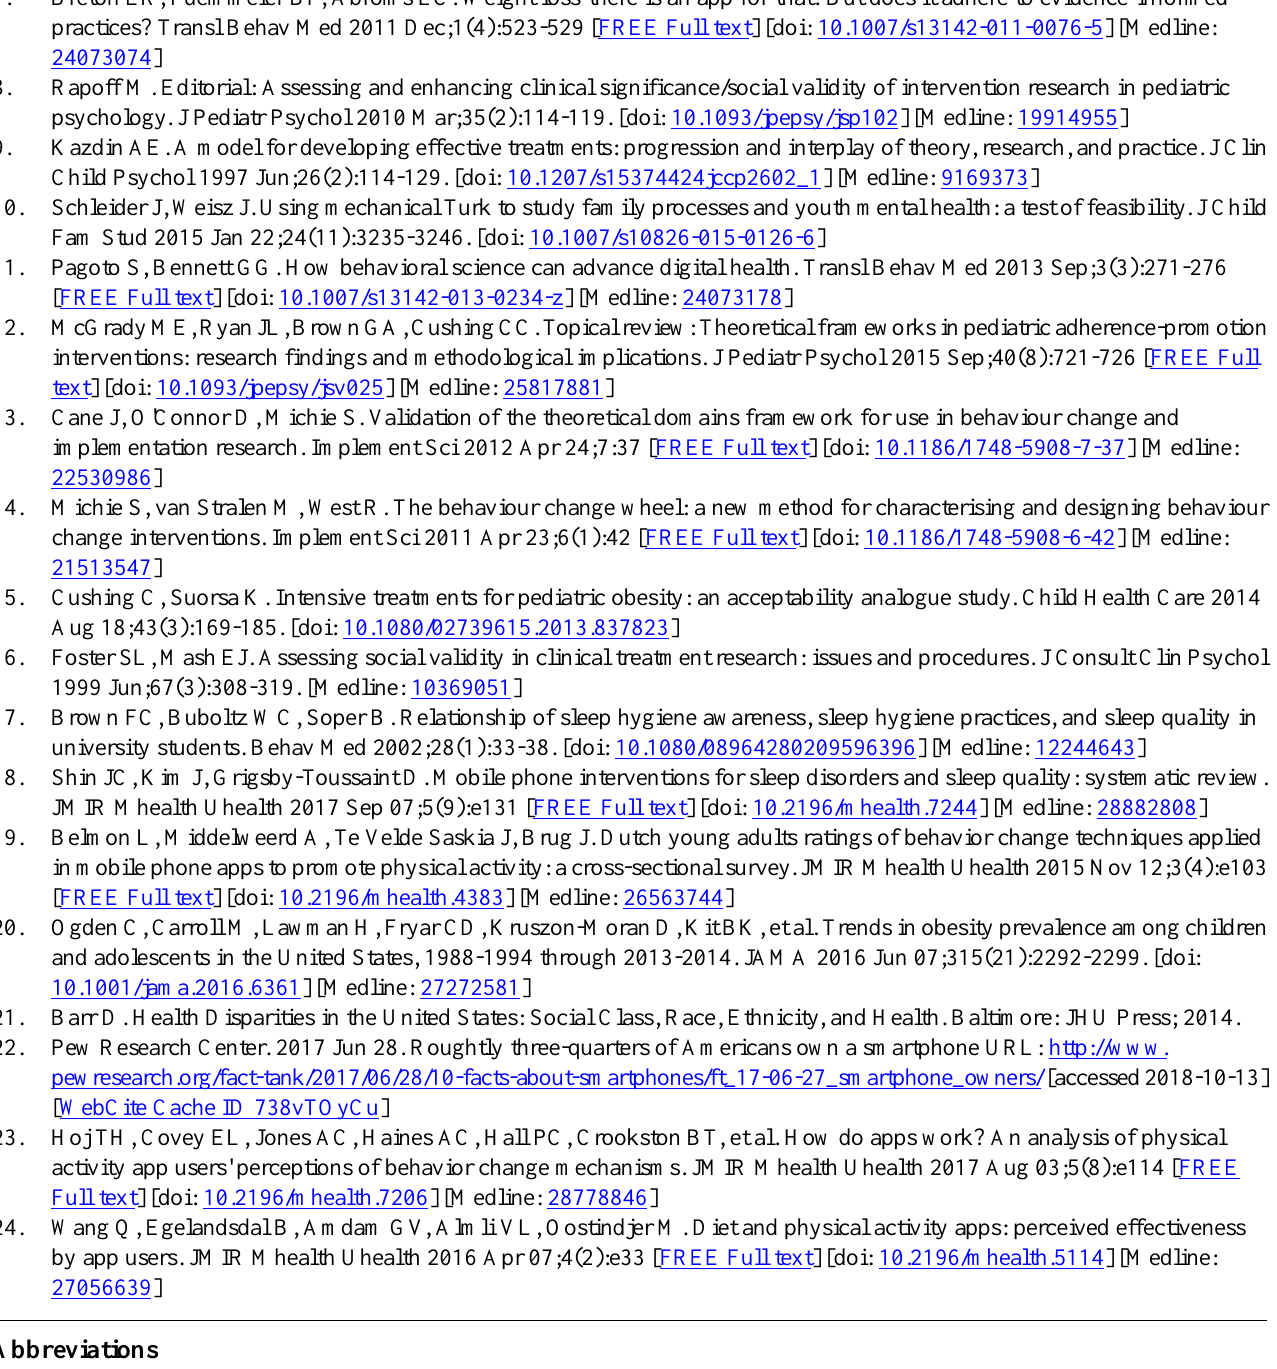
mHealth: mobile health TDF: Theoretical Domains